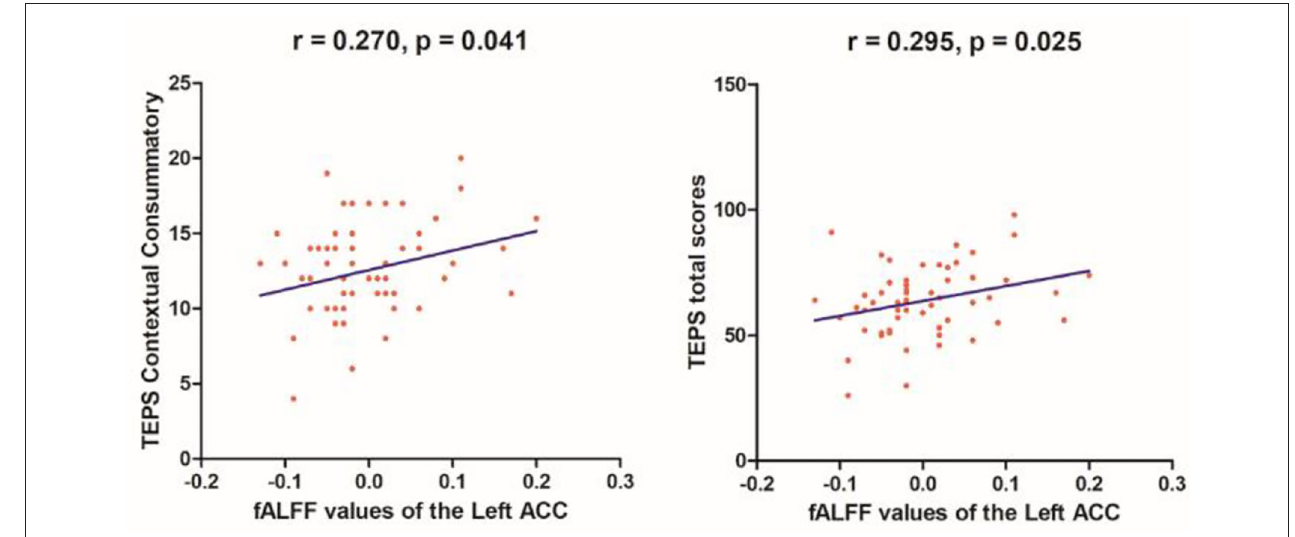
Frontiers in Psychiatry |